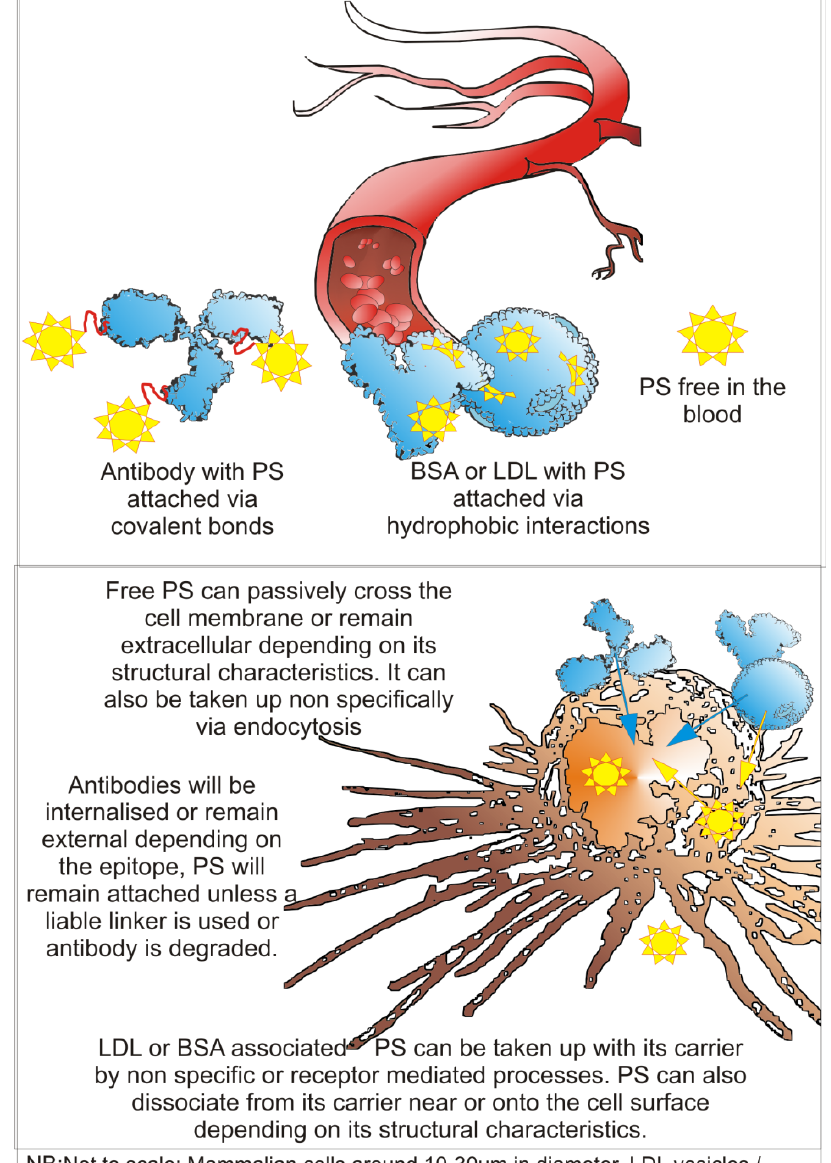
Figure 2. Schematic diagram illustrating non-targeted and targeted PDT. After extravasation from the vasculature system PS-drugs pass from the blood into the tumour microenvironment where depending on their physical properties and to what (if anything) they are attached, they can either diffuse into local cells or remain in the extracellular/cell surface environment. Particularly hydrophobic PS may be able to cross cellular membranes directly along their concentration gradient, PS-drugs that have associated with lipid- binding proteins such as LDLs (low-density lipoprotein) or HSA (human serum albumin) can get taken up piggyback or specifically via cell surface receptors. ADP refines this receptor delivery by using antibodies to deliver PS-drugs to cell-surface markers over- expressed on tumour cells; these can then specifically induce ADP-drug internalisation or not depending on the character of the targeted antigen. Either inside the cell or in the extracellular space, once exposed to light the PS-drug created singlet oxygen and other ROS which mediates cellular